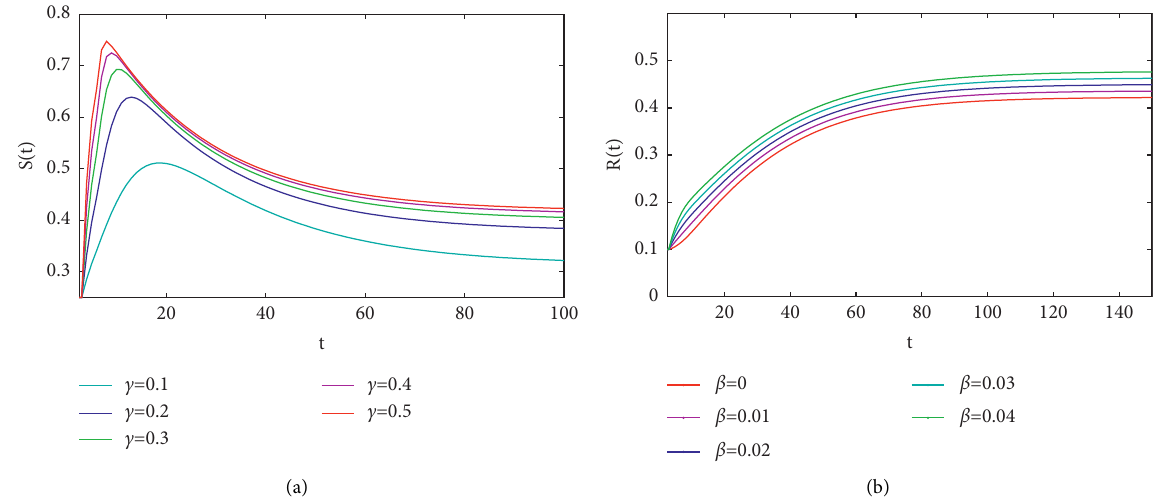
Figure 5: (a) The density of S ( t ) with different values of c , R